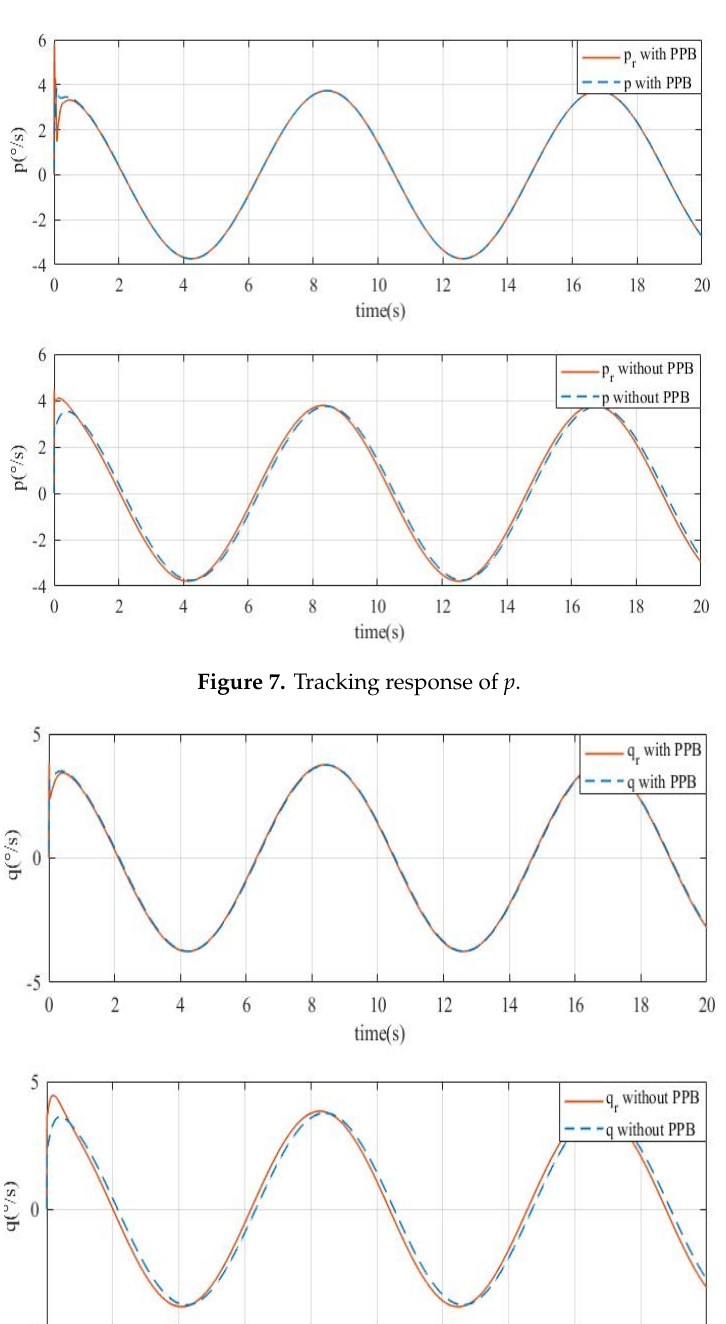
Figure 6. Tracking response of  .